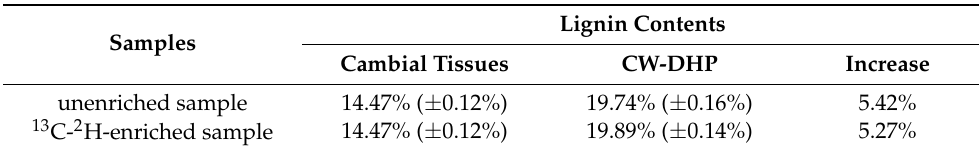
Table 2. Comparison of lignin contents before and after the culture of the soft cambial tissues of a ginkgo